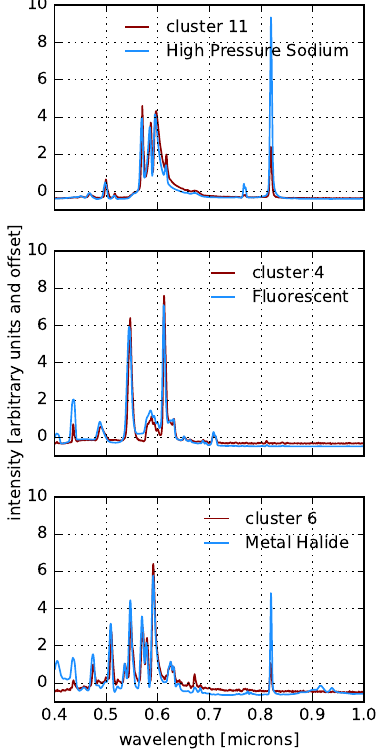
Figure 15. A comparison of several of the k -means cluster centers from Figure 14 with NOAA